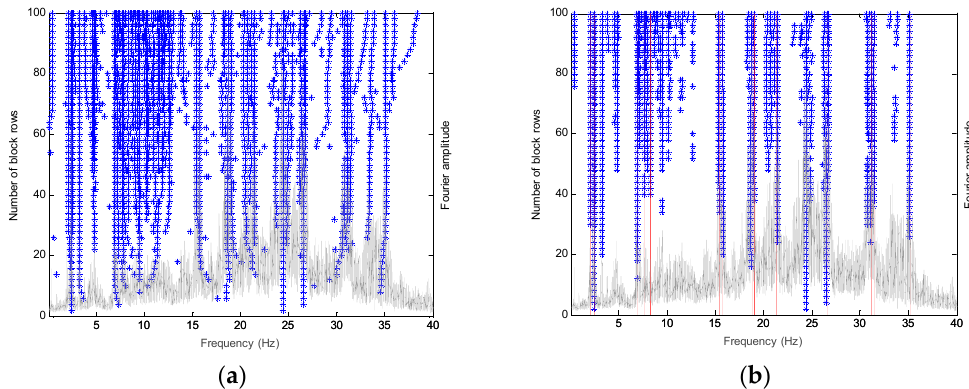
Figure 4. A typical stabilization diagram of the dataset measured at 13:00 of 12 April ( a ) before and ( b ) after it was cleared with the selected modes marked with vertical red lines.